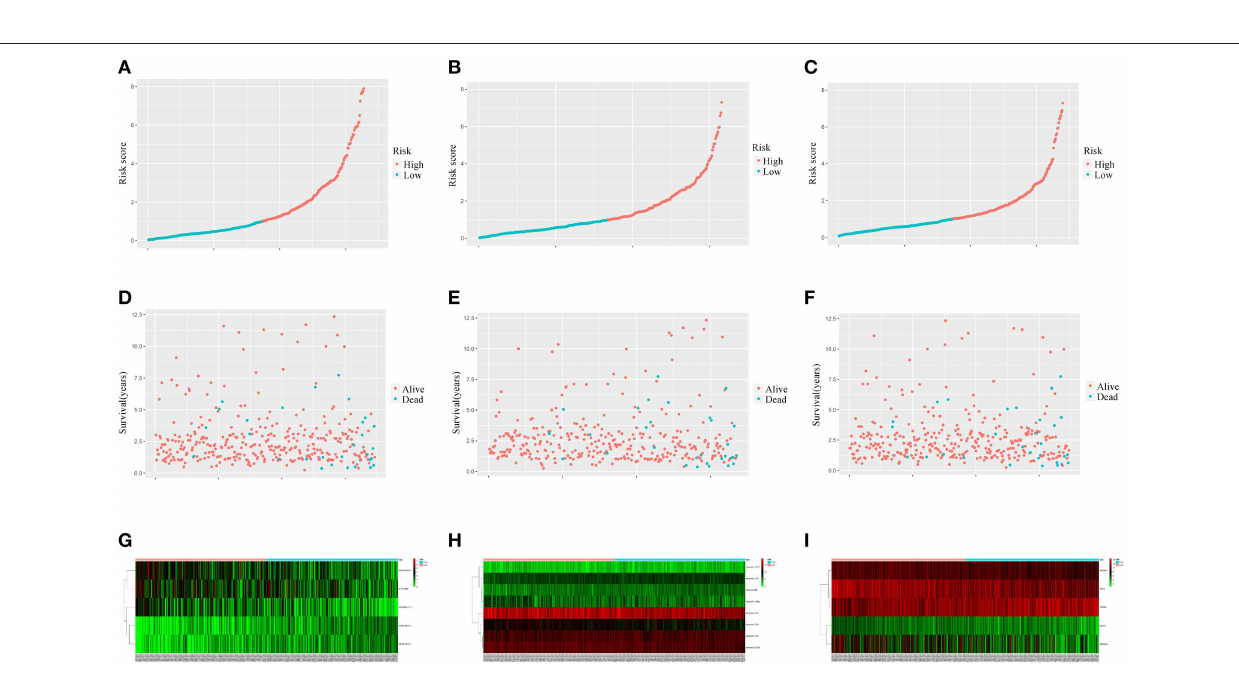
Frontiers in Oncology |